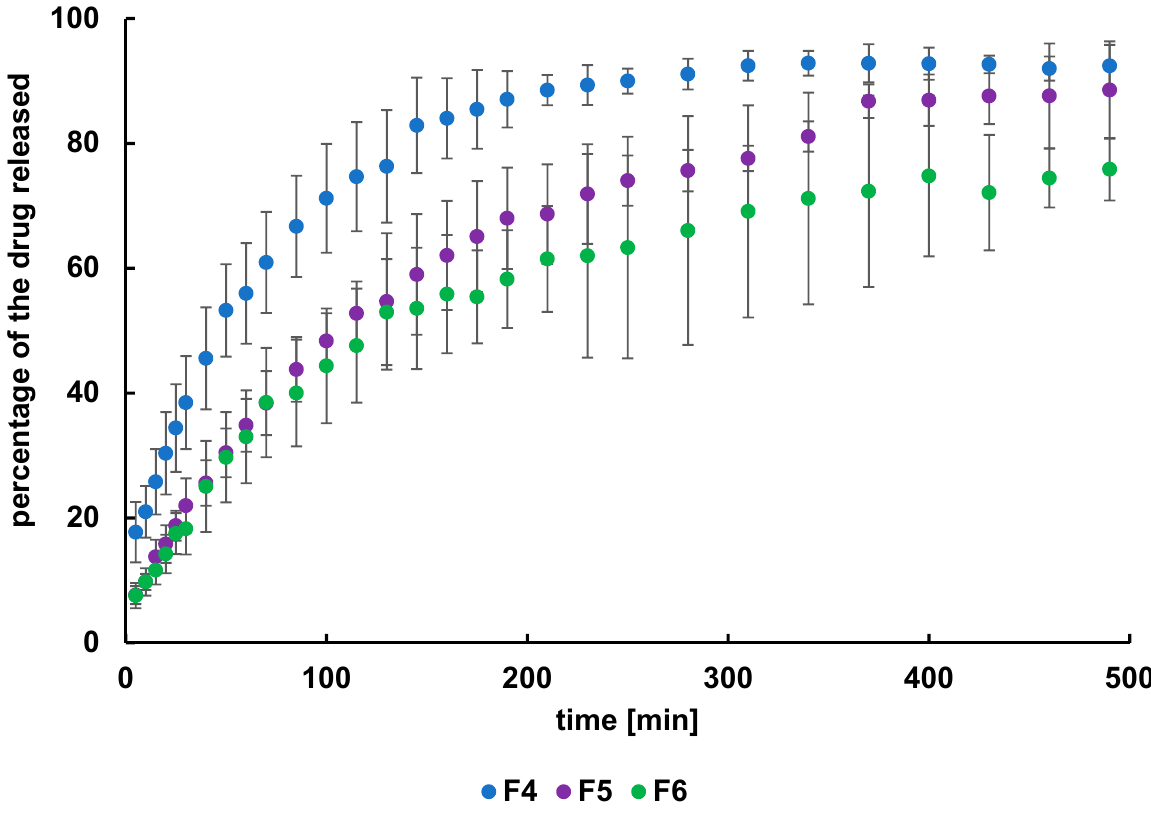
Figure 5. The release curves of L from formulations F4–F6.